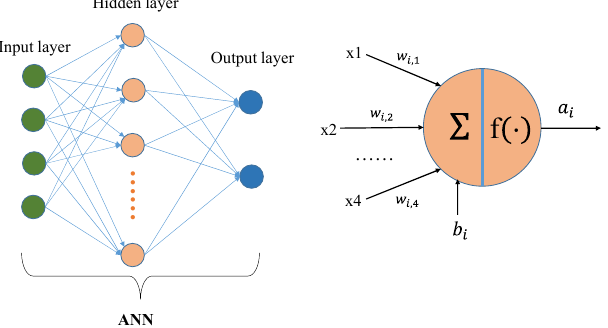
Figure 2. Architecture of the ANN.